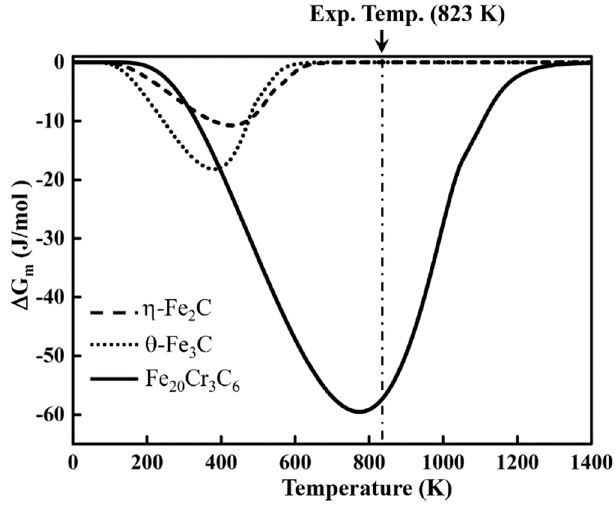
Figure 9. Magnetic-field-induced free energy change of η -Fe 2 C, θ -Fe 3 C and Fe 20 Cr 3 C 6 with a 12 T external field.